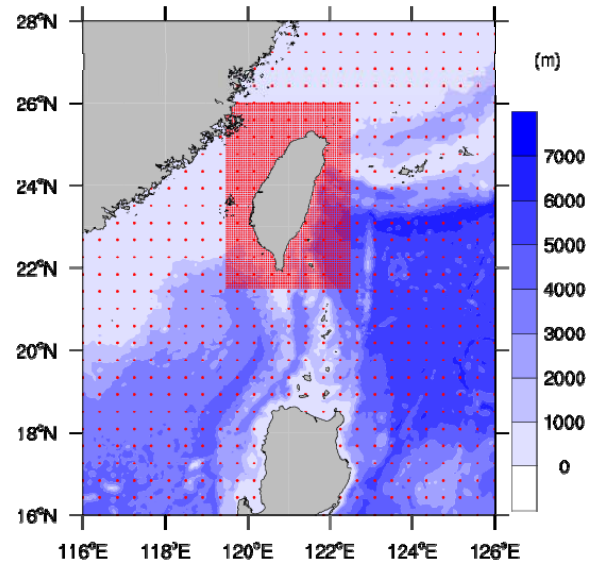
Figure 7 Nested grids used for numerical wave models. Whole domain – NWWIII Fig. 7. Nested grids used for numerical wave models. Whole do- model, grid size is 45 km. Central regional domain – SWAN, grid size is 0.5km. main – NWWIII model, grid size is 45km. Central regional domain – SWAN, grid size is